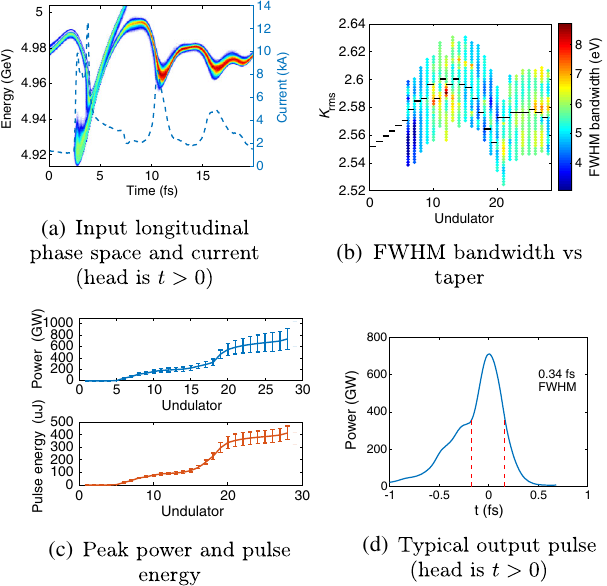
FIG. 5. Simulation of isolated attosecond x-ray pulse gener- ation from a self-modulated electron beam. Each simulation is repeated 10 times with different shot noise. (d) shows the power profile of a typical shot.